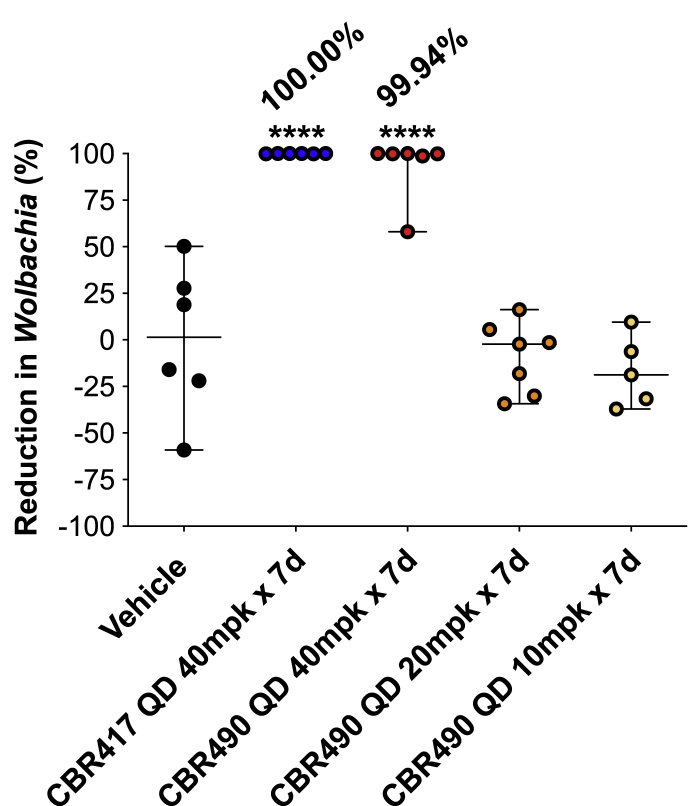
High content imaging of ovaries showa highly significant reduction inWolbachiafrom femaleB. pahangiworms recovered from jirds treated with 40 mg/kg QD x 7 days CBR417 (P < 0.0001) and CBR490 (P < 0.0001). Ovaries from individual females were removed and stained with Wolbachia specific 16S rRNA probes using fluorescence in situ hybridization (FISH) and DAPI. Ovaries were imaged using confocal microscopy and Wolbachia quantified using high content image analysis. Means ± SD (average signal from 1 to 2 ovaries from 5 to 7 worms per treatment) are shown, and mean elimination (%) is reported. To assess significance between the vehicle control and treatment groups a one-way ANOVA with Dunnett's multiple comparisons test was used (****P < 0.0001).